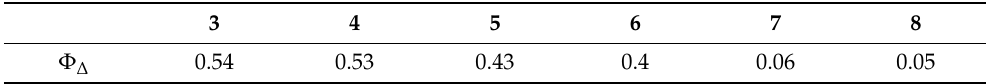
Table 5. The IC 50 values of 3 , 4 , 5 , 6 , 7 , 8 against 5637, LNCaP, and A375 cells. Data are expressed as the mean ±SD from at least three independent experiments.